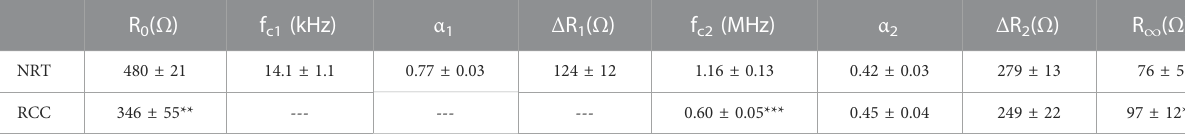
TABLE 1 The characteristic parameters of normal renal tissue and renal cell